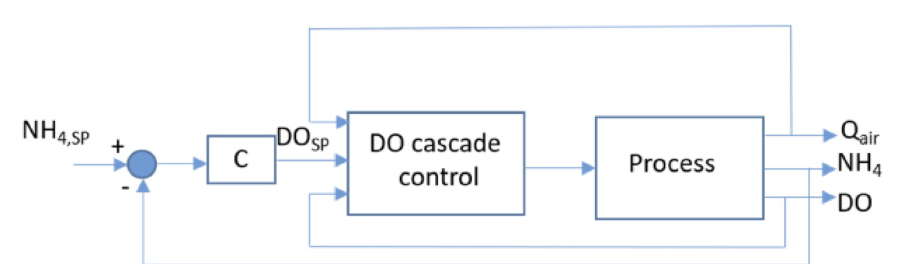
Figure 3. Ammonium-based control: feedback